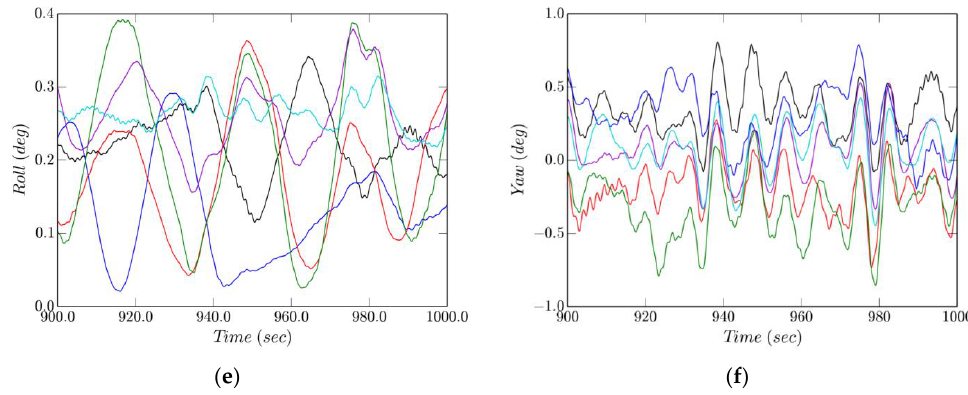
Figure 7. WT2 motions of ( a ) surge, ( b ) heave, ( c ) pitch, ( d ) sway, ( e ) roll, and ( f ) yaw for various lateral positions.